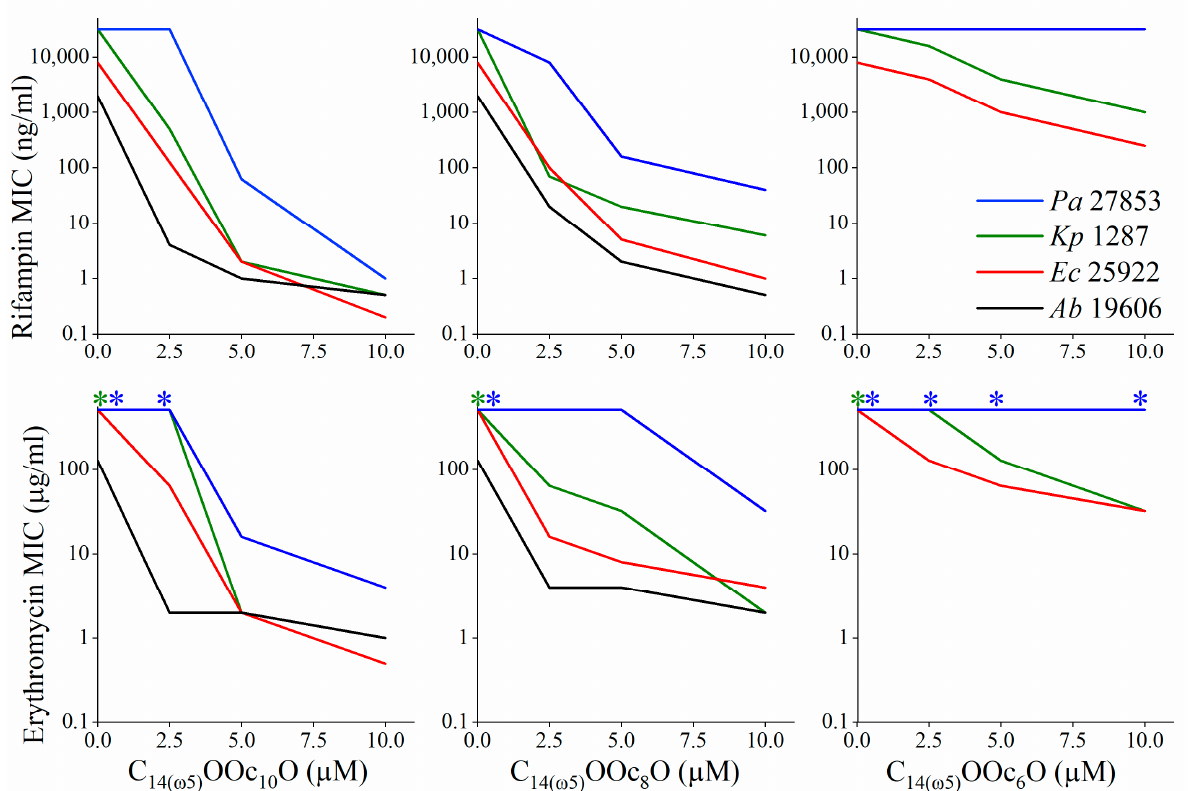
Figure 4. Hydrophobicity dependence of antibiotics potentiation by lipopeptide analogs. Sensitization of GNB to rifampin and erythromycin (upper and lower panel, respectively) was assessed by MIC experiments performed in LB medium, in presence or absence of an OAC analog whose A 2 position was gradually shortened (from c 10 to c 6 ). Pseudomonas aeruginosa 27853 ( Pa , blue), Klebsiella pneumoniae 1287 ( Kp , green), Escherichia coli 25922 ( Ec , red), and Acinetobacter baumannii 19606 ( Ab , black) . Asterisks (*) denote MIC values greater than the highest tested concentration (i.e., >512 μ g/mL).